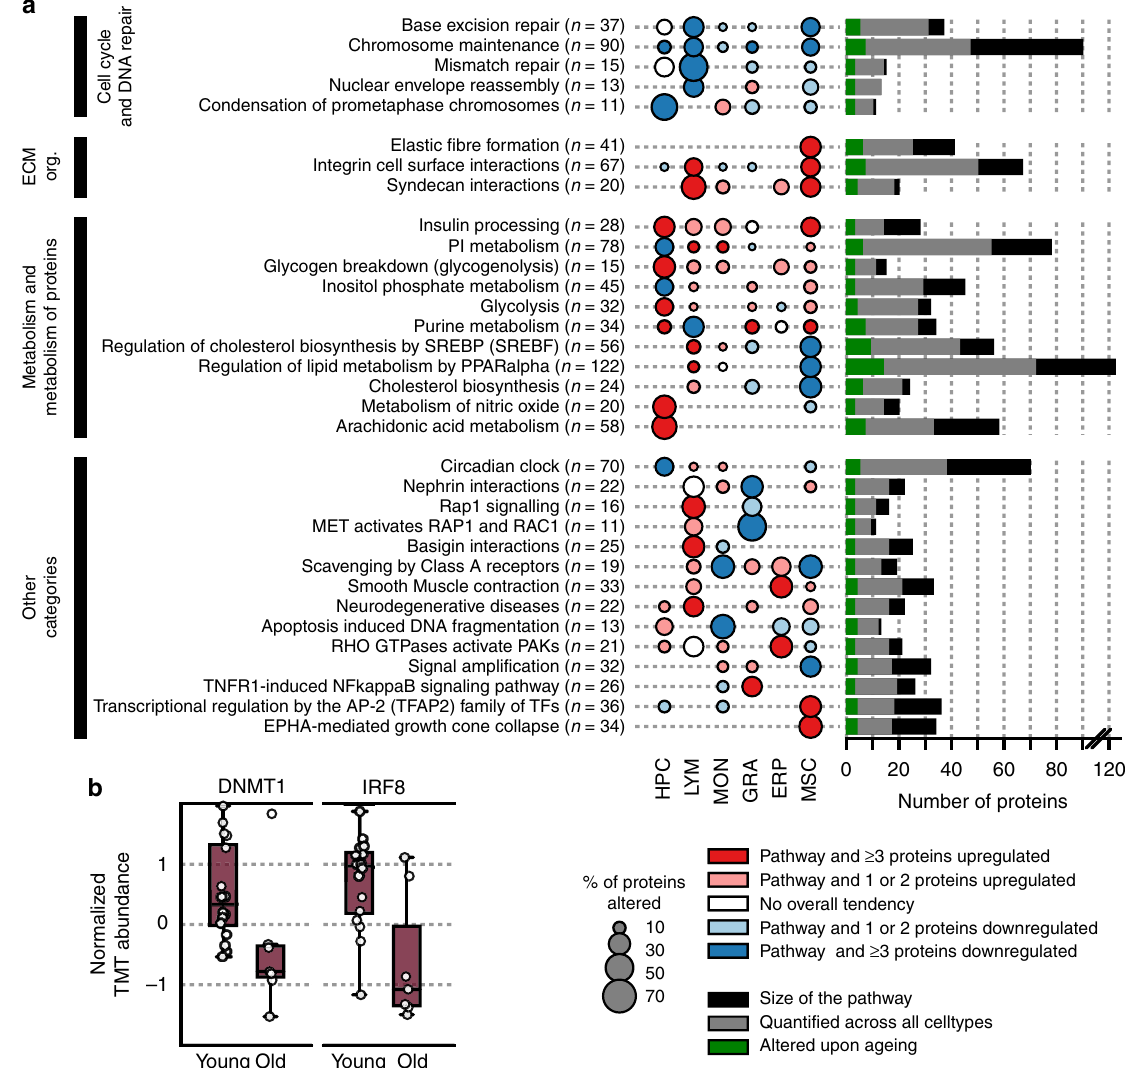
Fig. 3 Age-affected pathways in the individual cell populations. a A selection of pathways from the Reactome database that show the most prominent changes upon ageing are depicted. Pathways were required to have between 5 and 150 members to be suf fi ciently covered in at least one cell population (>30% of the proteins are quanti fi ed), and to have at least 20% of its quanti fi ed components being signi fi cantly ( p value < 0.05, Spearman's correlation) altered upon ageing. The fi gure illustrates the fi ve most up- and down-regulated pathways for each cell population. The area of the bubbles represents the percentage of proteins quanti fi ed by TMT that are signi fi cantly ( p value < 0.05, Spearman's correlation) altered. If no bubble is shown, no protein of the pathway was signi fi cantly altered in the respective cell population or no protein of the pathway has been quanti fi ed. Red indicates an overall increase of the pathway members with at least three proteins being up-regulated and pink indicates an overall increase with one or two proteins being up-regulated. Blue codes for pathways with an overall trend towards downregulation, with dark blue coding for pathways with at least three proteins being down-regulated and light blue containing one or two proteins being down-regulated. The colour white indicates that no overall tendency could be observed. The bars on the right-hand side of each pathway illustrate the number of proteins being signi fi cantly altered upon ageing regardless of the cell population (green), being quanti fi ed by TMT (grey), and the total number of members of the pathway (black) as also mentioned in the pathway annotation ( n ). The grouping of the pathways on the left side is based on the highest hierarchy levels de fi ned in Reactome, e.g., extracellular matrix organization (ECM org.). b Effect of ageing on the abundance of DNMT1 and IRF8 in HPCs. The dots represent the individual results from young (age < 30 years) and old (age > 50 years) human subjects. The central line in the box plots indicates the median, the bottom and top edges of the box the interquartile range (IQR), and the box plot whiskers represent 1.5 times the